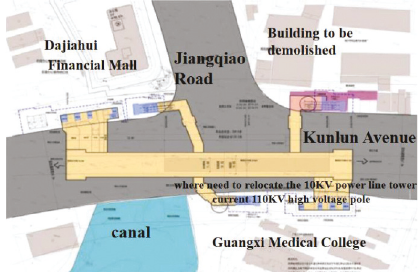
Figure 5: General layout of Jiangqiao station.